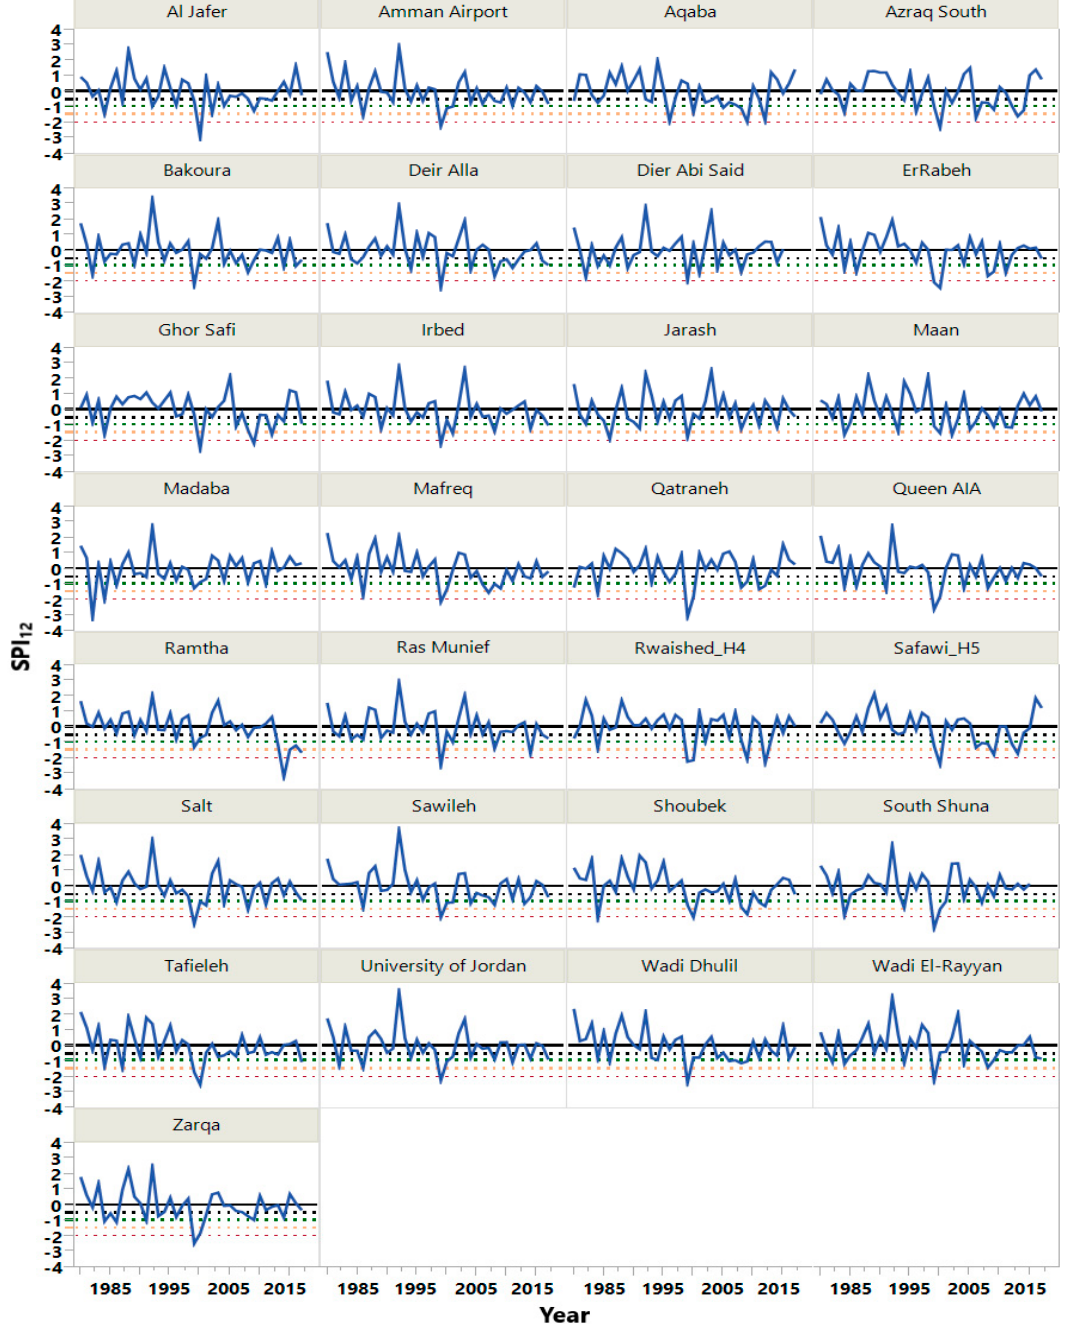
Figure 4. Annual standardized precipitation index (SPI 12 ) values for each station 1980–2017. Table 4. Linear trend analysis for standardized precipitation index over time.